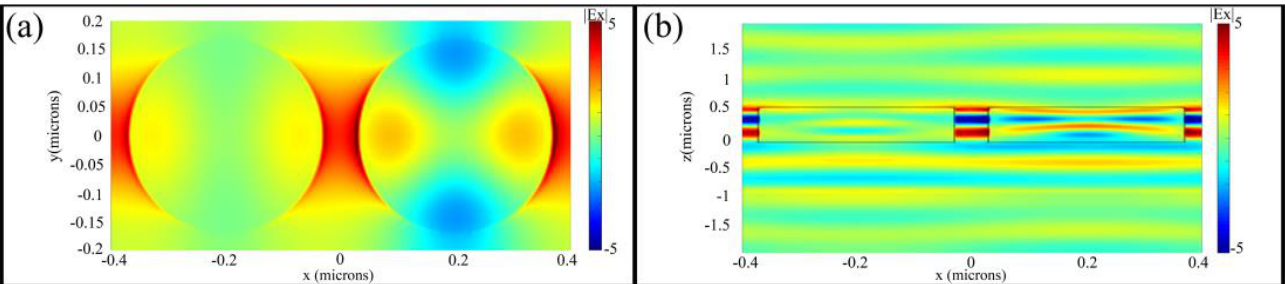
Figure 3. ( a , b ) the electric near field real(Ex) distribution in xy-plane and xz-plane by commercial software FDTD Solutions (Lumerical Inc.). The applied voltages of the left and right antennas are 15 V and 35 V, respectively.